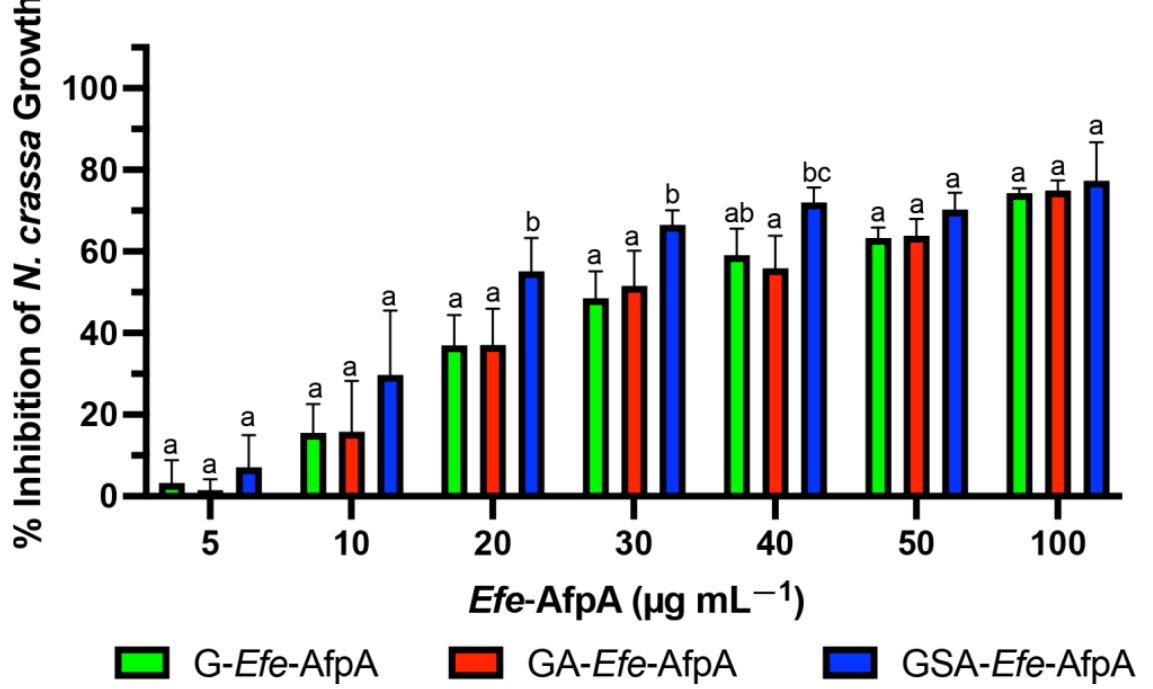
Figure 1. Comparison of activity of bacterially produced Efe -AfpA with varying N-terminal amino acids. Increasing concentrations of the modified Efe -AfpA proteins were assayed for activity in the N. crassa growth assay with 1 × 10 6 conidia mL − 1 . The data presented are the means and standard deviations of three replicates. For each concentration, columns with different letters indicate a significant difference in activity ( p ≤ 0.05, two-way